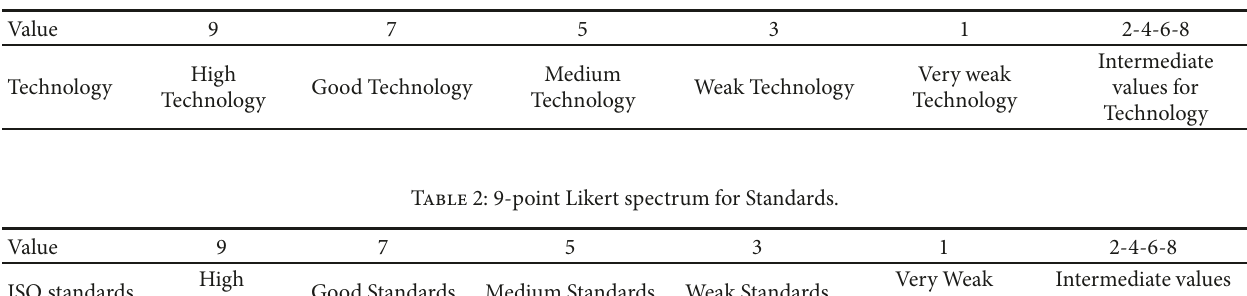
Table 1: 9-point Likert spectrum for Technologic power.